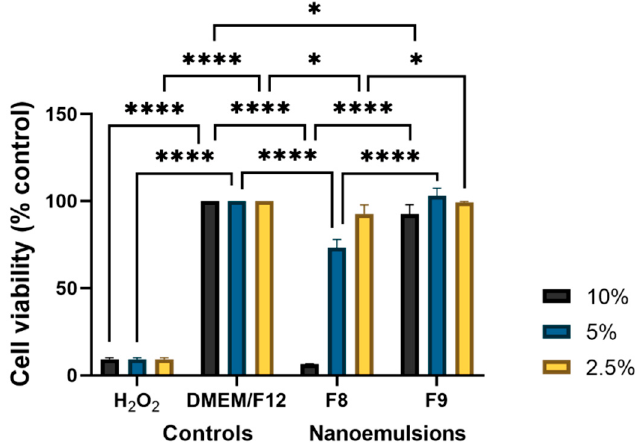
Figure 3. HMC3 cells viability after exposure to F8 and F9 for 24 h, at three different concentrations (10%, 5% and 2.5%). Cell culture medium (DMEM/F12) and culture medium supplementation with 1 mM H 2 O 2 were used, respectively, as negative and positive controls. The results are the mean of three replicates, and the bars represent the mean ± standard deviation (SD). Statistical significance * p < 0.05; **** p < 0.0001. Abbreviation: H 2 O 2 , hydrogen peroxide.